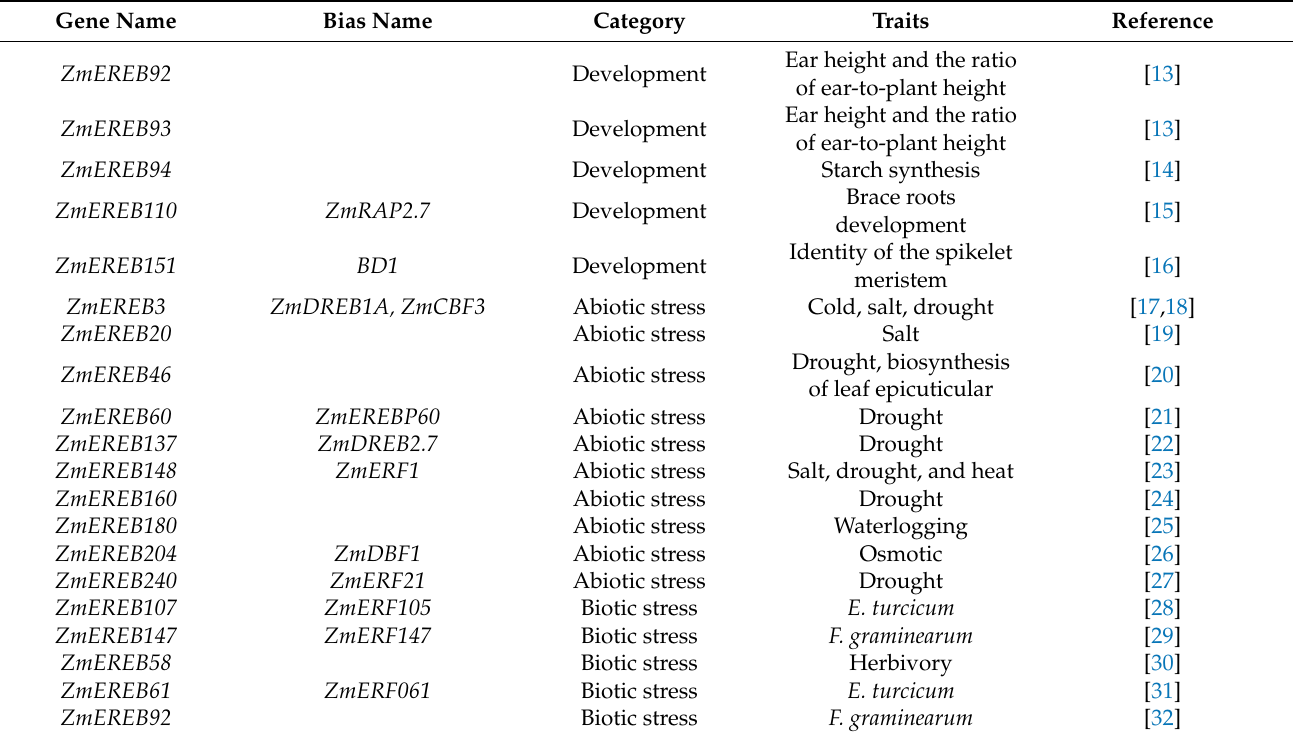
Table 1. The information of cloned-AP2/ERFs in